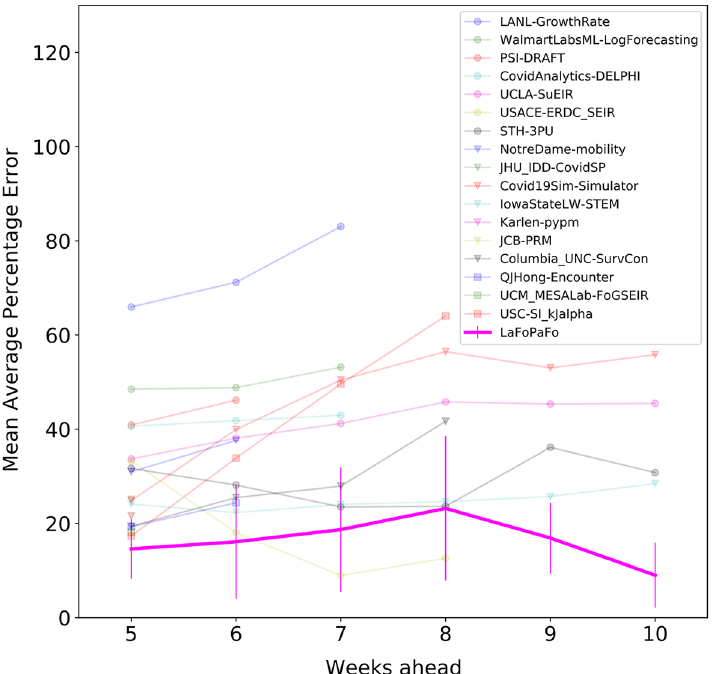
Figure 1. Forecast accuracy of the projected weekly number of reported COVID-19 deaths in the US. The accuracies of the 17 predictive models submitted to the CDC, as well as LaFoPaFo, on forecasting the weekly average (non-cumulative) number of deaths in the US for each of the 7 weeks starting from September 27 to November 14, 2020. We could only consider six test weeks for the future 10-weeks predictions as insufficient training instances were available before the week September 21–27. For each of these 7 weeks, we recorded the forecasts made by each model, for 5 to 10 weeks ahead, and compared each forecast to the true value. We then computed the MAPE for each model and time-horizon as the average over the 7 weeks, depicted with a single point in the graph. The vertical purple lines are the error bars of LaFoPaFo and are computed as the standard deviation over the seven MAPEs. Note the forecasting results for the CDC models were taken from the tables at the forecast hub website. Most CDC models did not submit forecasts for long-range horizons; only five models submitted the forecast results for the future 10 weeks. We see that LaFoPaFo is the most accurate forecaster over the 5, 6, 9 and 10 week forecast horizons, with a significant difference for 9 and 10